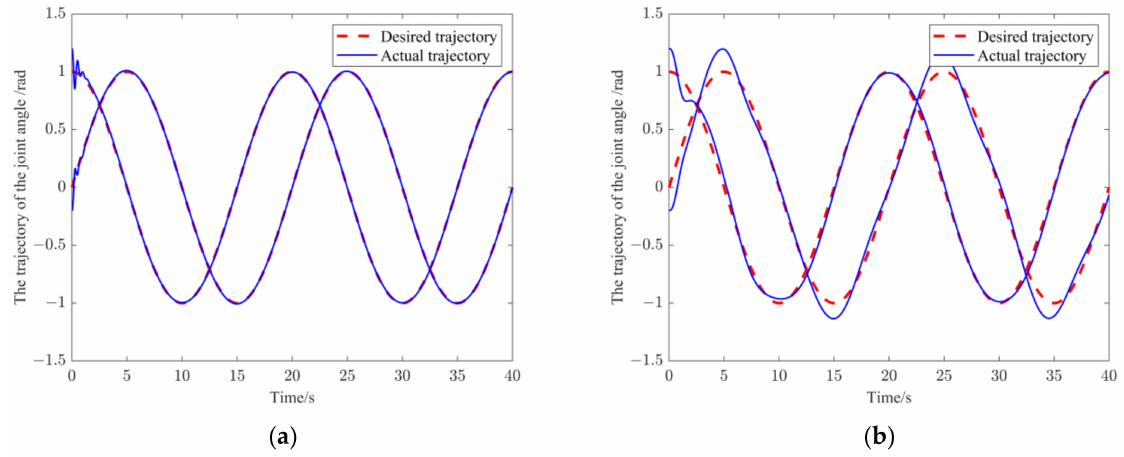
Figure 20. The trajectories of the joint angle q